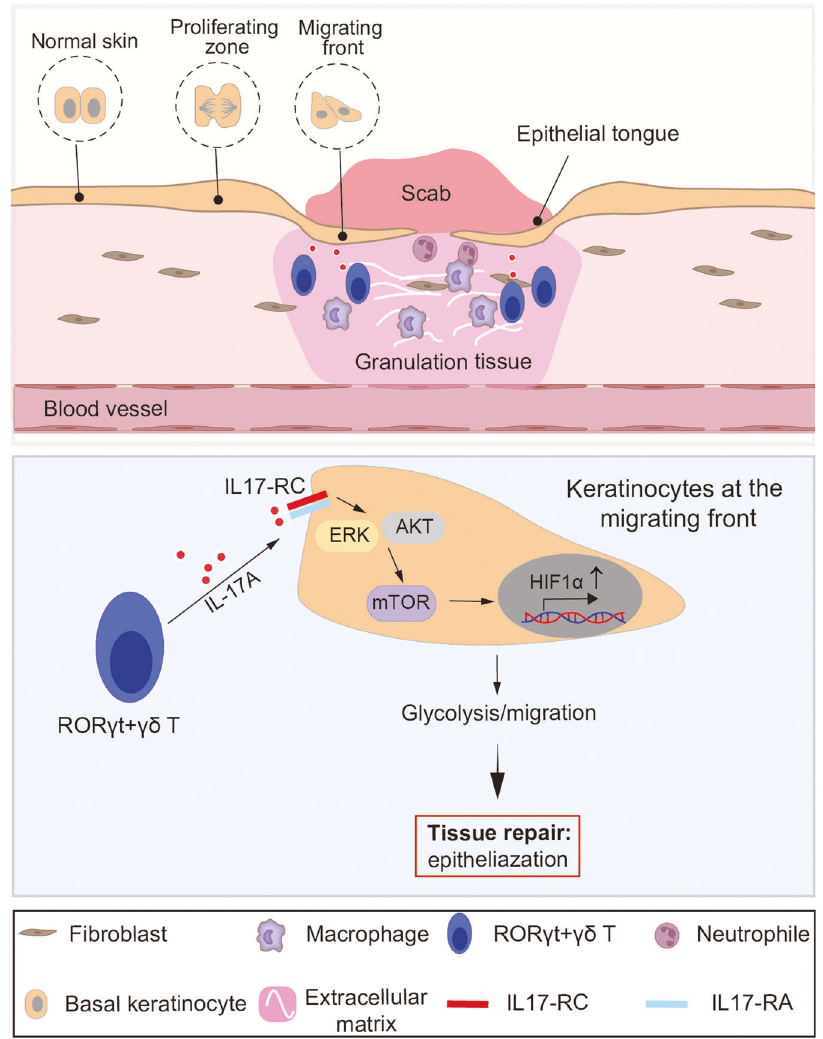
Fig. 1 IL-17A signaling promotes epithelization by shaping wound epithelial cell metabolism. (Top) The scheme illustrates cellular networks involved in wound healing progression. Upon injury, immune cells, including neutrophils, macrophages, and lymphocytes, initiate an in fl ammatory response, which orchestrates wound healing progression. Fibroblasts become myo fi broblasts, contributing to granulation formation. The activated keratinocytes at the wound edge migrate over the freshly formed granulation, re-epithelizing and restoring skin barrier function. Konieczny and colleagues report that ROR γ t + γδ T-cell-derived IL-17A regulates wound epithelization. (Bottom) ROR γ t + γδ T-cell-derived IL-17A signaling is required for the glycolytic metabolism and migration of wound epithelial tongue cells. IL-17A binds to its receptor IL-17-RC and induces HIF1 α expression through ERK/AKT activated mTOR signaling. IL-17A-HIF1 α signaling axis-mediated glycolytic metabolism is essential for the migratory activity of wound keratinocytes, thereby regulating wound